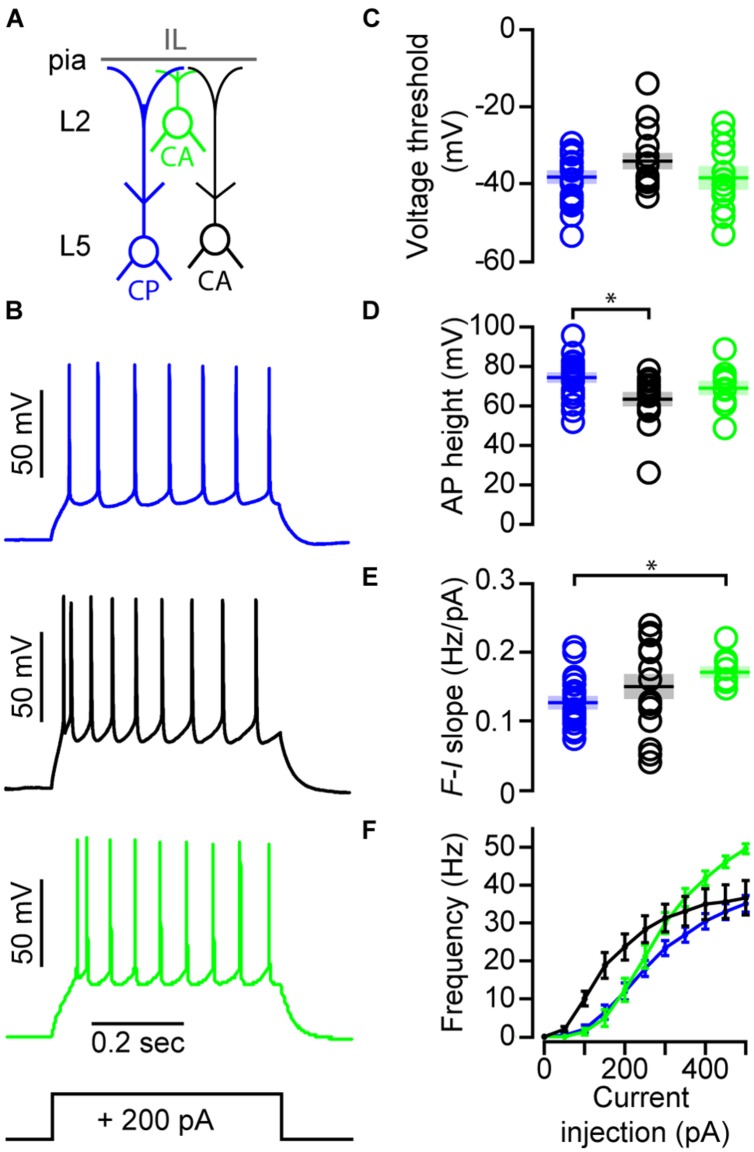
Firing properties differ between CP and CA neurons in IL. (A) Schematic showing the subclasses of neurons recorded. (B) Examples of action potential firing across projection class. (C) Voltage threshold, (D) AP height (*p < 0.05, Kruskal–Wallis test), (E) AP frequency-current slope (*p < 0.05, one-way ANOVA), and (F) AP frequency-current comparisons between CP (n = 26), L3/5 CA (n = 20), and L2 CA (n = 10) neurons. Shaded area = SEM.